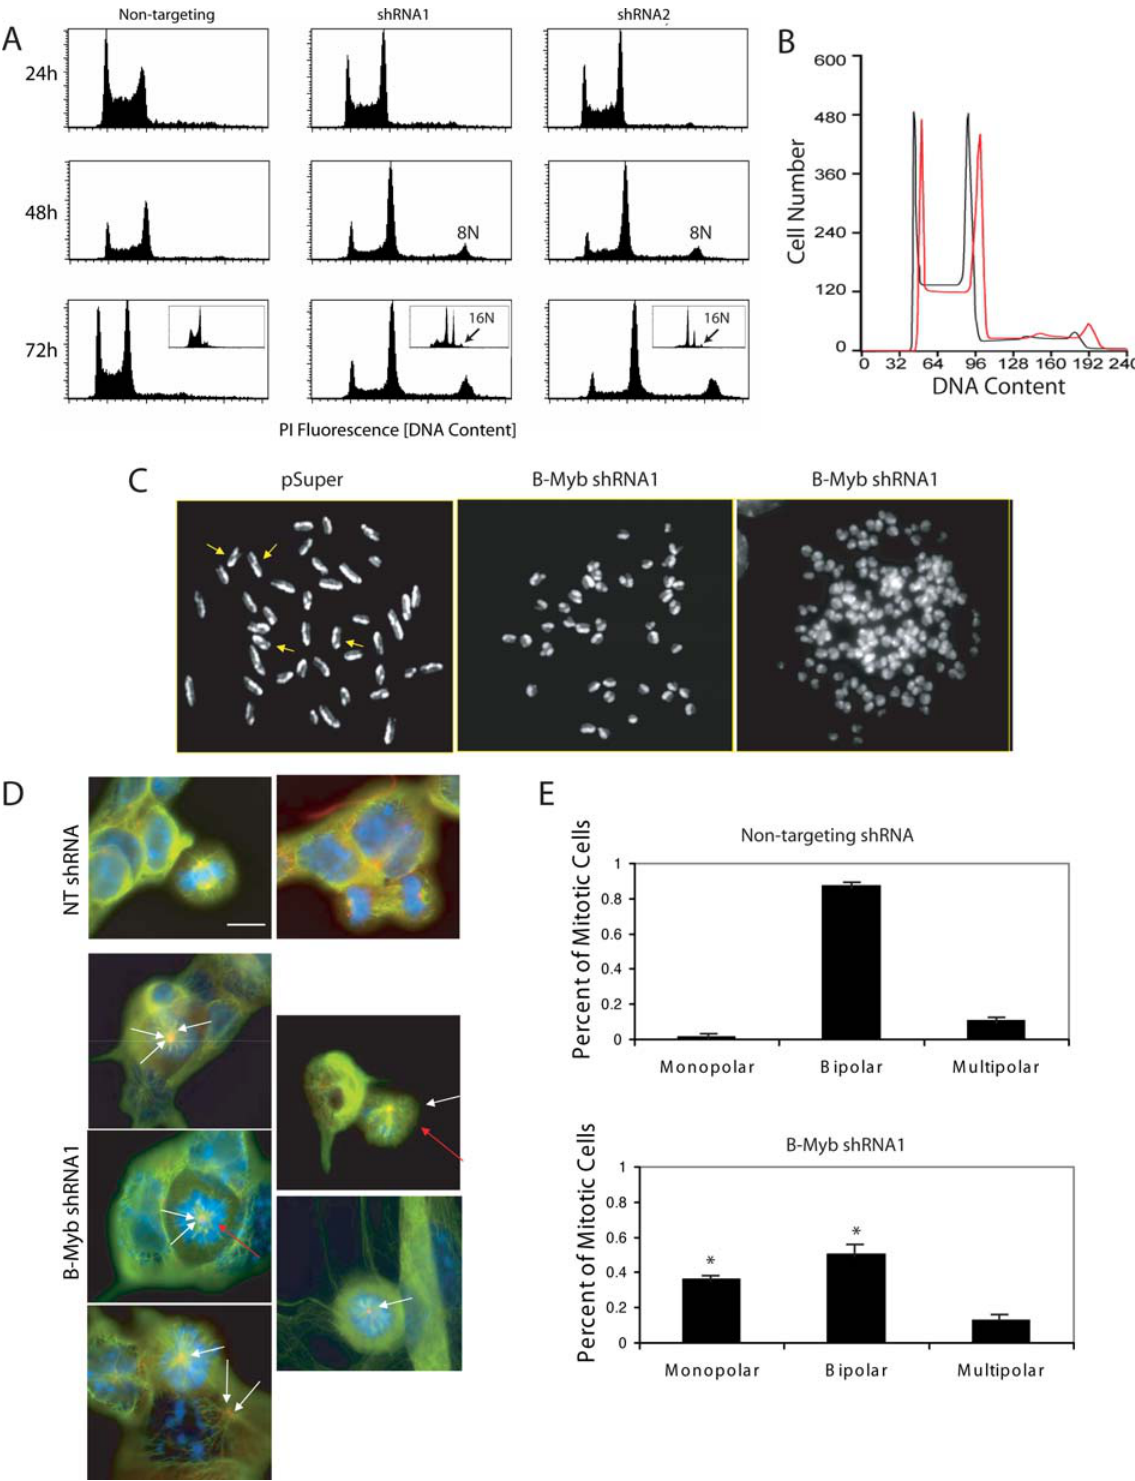
Figure 4. DNA analysis of R1 ES cells. A) DNA content was measured by flow cytometry in non-synchronized ES cells that had been fixed and stained with propidium iodine following nucleofection with shRNA. At 24 hours after nucleofection with shRNA1 and 2, the number of cells in S phase decreased concomitant with an increase in the number of cells in G2/M relative to controls. At 48 hours, knockdown of B-Myb led to increased octoploidy (8N), and the incidence of octoploidy was increased further at 72 hours (p , 0.05). At this time, cells with a 16N and 32N (not shown) complement of DNA were also detectable (see arrows in the inset, Logscale). B) In these experiments, ES cells were transfected with either a NT shRNA (black line) or shRNA1 and selected by puromycin for 24 hours. Within 96 hours, the selected cells began to recover and proliferate, and within one week, cells transfected with shRNA1 demonstrated a rightward shift in the cell’s DNA content, indicating that these surviving and proliferating cells were karyotypically abnormal (i.e., aneuploid). C) Metaphase chromosome spreads after labelling in the presence of BrdU for